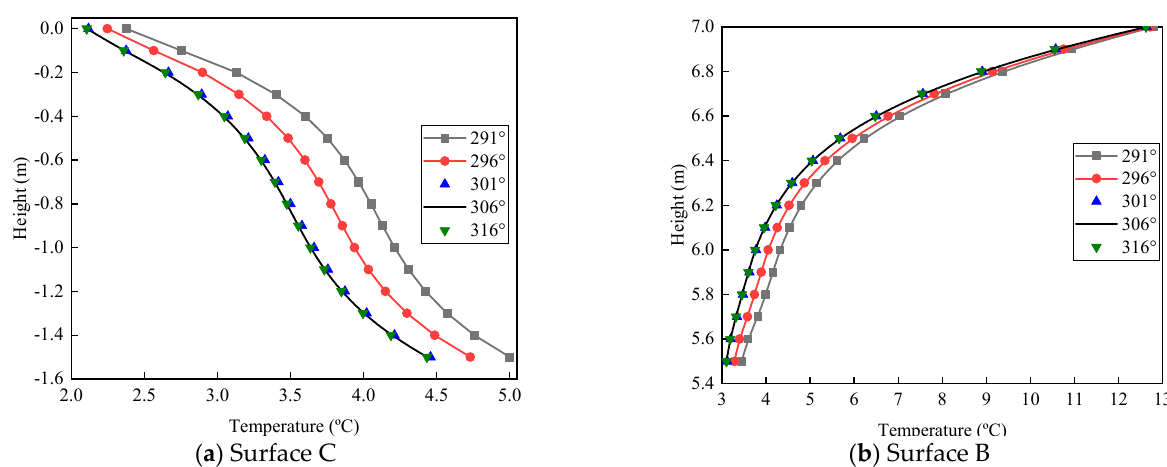
Figure 23. Temperature gradients with different directions of the aqueduct (angles represent azimuths of vertical surfaces on the western part of the aqueduct).